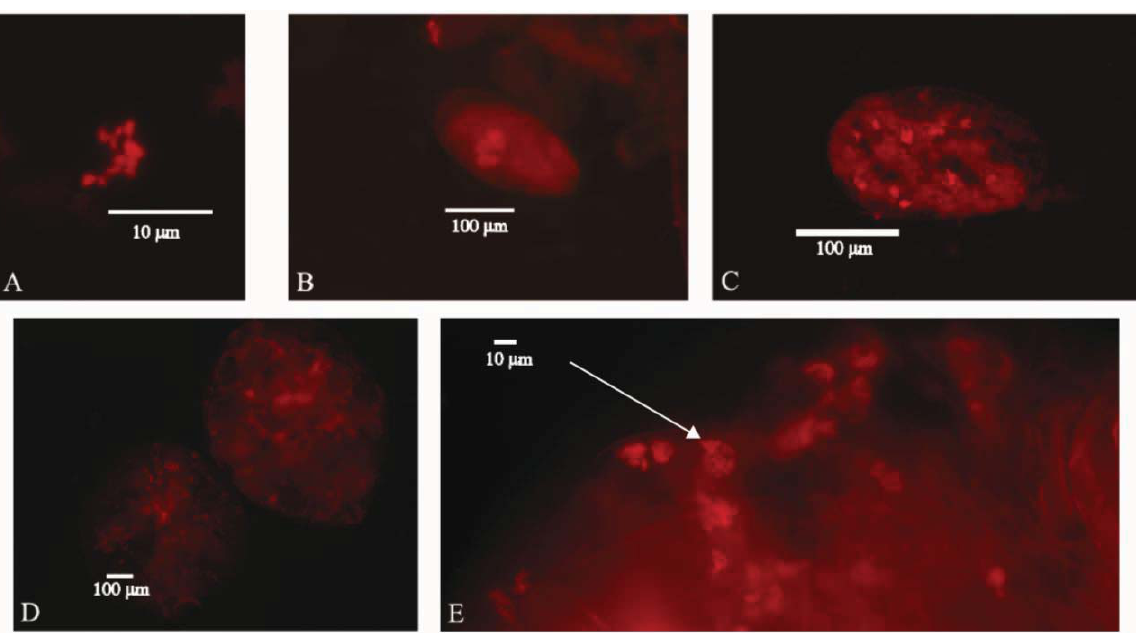
Figure 1. In situ hybridization images of the bacterial endosymbiont Uzinura diaspidicola from various armored scale insect species. Image ( A ) Individual bacteria from Diaspis echinocacti , ( B ) Diaspis echinocacti embryo ( C ) Single Chionaspis pinifoliae egg from. ( D ) Two whole Hemiberlesia lataniae adult female insects ( E ) Partial Hemiberlesia lataniae adult showing internal embryo and arrow denoting symbiont pocket in an single